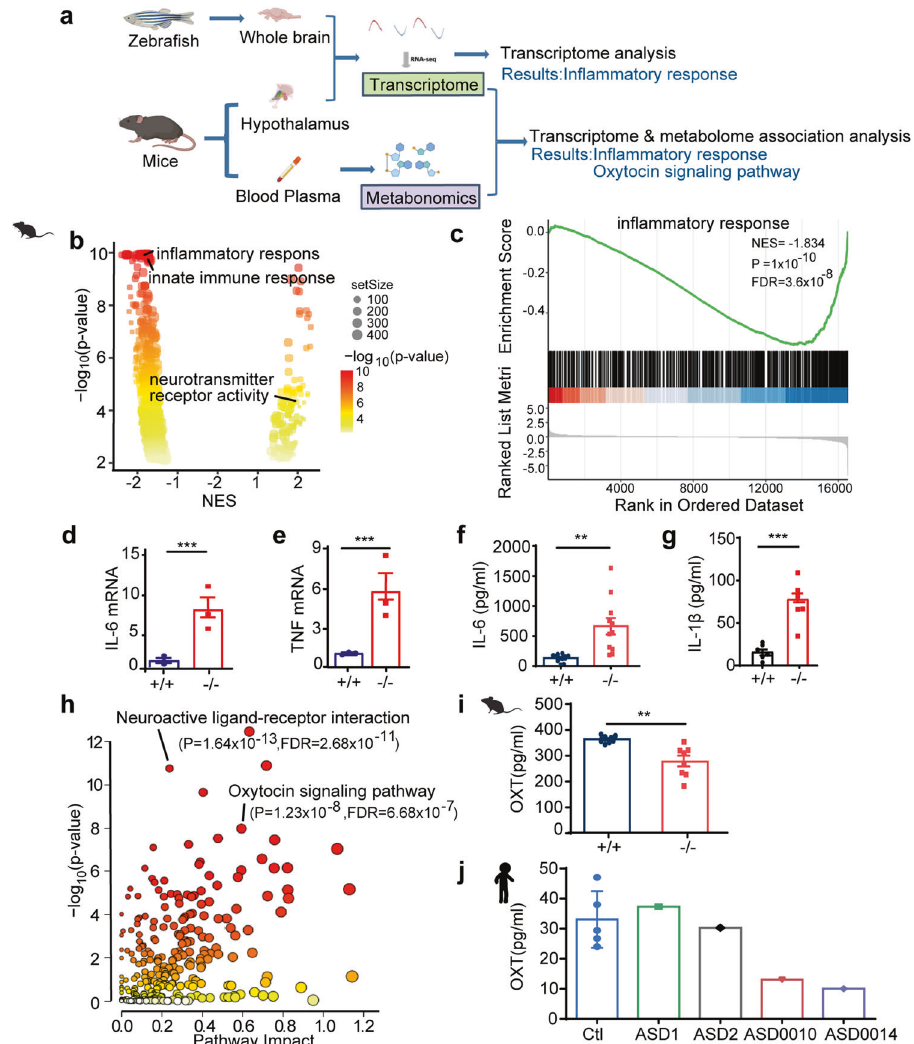
Fig. 4 Integrated omics identify SCGN as a key regulator of immune response and oxytocin signaling pathways. a Multi-omics pro fi ling of zebra fi sh and mice samples. Zebra fi sh whole brain and Mice hypothalamus were extracted for transcriptome analysis. Mice serum was collected for metabolome analysis. Transcriptome and metabolome from mice were further integrated for association analysis. b Volcano plots of GSEA results based on differentially expressed genes in the hypothalamus of scgn + / + and scgn − / − mice. The dot color indicated the − log 10 p -value in each pathway, while the dot size represented the gene number of each pathway. NES Normalized Enrichment Score. Volcano plots shows in fl ammatory and immune response pathways were signatures based on mice transcriptome analysis. c GSEA plot shows the signatures of the immune response in hypothalamu transcriptomes by scgn − / − mice compared to scgn + / + mice. NES Normalized Enrichment Score. P, p -value. FDR False Discovery Rate. d , e Relative mRNA expression of immune and in fl ammation related genes upon brain tissue in scgn + / + and scgn − / − mice after exposure to Bleed challenges ( n = 3). d IL-6; e TNF. N = 3 for each group. Data were presented as mean ± SD, P - values were calculated using one-way ANOVA, Tukey ’ s multiple comparisons test. *** p < 0.001, ** p < 0.01, * p < 0.05, ns not signi fi cant. f Plasma IL-6 protein level is increased in scgn − / − mice relative to control. ** p < 0.01. Differences among groups by unpaired Student t -test. Experiments above were repeated three times. g Plasma IL-1 β protein level is increased in scgn − / − mice. *** p < 0.001. P -values were calculated using unpaired Student t -test. Experiments above were repeated three times. h Mice transcriptome& metabolome association analysis reveals difference of oxytocin signaling pathways and neuroactive ligand-receptor interaction. i Plasma oxytocin concentrations of scgn − / − mice is decreased. N = 8 for each group. Data were presented as mean ± SD, P -values were calculated using one-way ANOVA, Tukey ’ s multiple comparisons test. ** p < 0.01. j Plasma concentrations of oxytocin in 3 control individuals, 2 ASD children without scgn mutation, ASD0010 and ASD0014 proband. ASD0010 and ASD0014 showed a lower plasma oxytocin levels than control and ASD1, ASD2. Ctl: control, healthy children; ASD1 and ASD2: ASD probands who do not carry scgn mutations; ASD0010: ASD individual carries mutation SCGN p.R79W; ASD0014: ASD individual with mutation scgn c.702 + 2 T > G. All individual in this test ages are around 3 years old. Experiments above were repeated three times Speci fi cally, principal component analysis (PCA) of transcrip- hormone secretion, 29 we analyzed the serum metabolome differences tome analysis in mouse brain based on rlog values of all expressed between Scgn + / + and Scgn − / − mice (Fig. 4a). Collectively, these omics genes showed that gene expression in Scgn-de fi cient animals was data suggested that SCGN de fi ciency affected similar pathways in substantially different than in control mice (Supplementary Fig. zebra fi sh and mice. Remarkably, pro fi les from both animal models 4a). Gene Set Enrichment Analysis (GSEA) indicated that the exhibited comparable alterations in signaling activities found in ASD differentially expressed genes (DEGs) that distinguished the two probands with SCGN mutations. Signal Transduction and Targeted Therapy (2023)